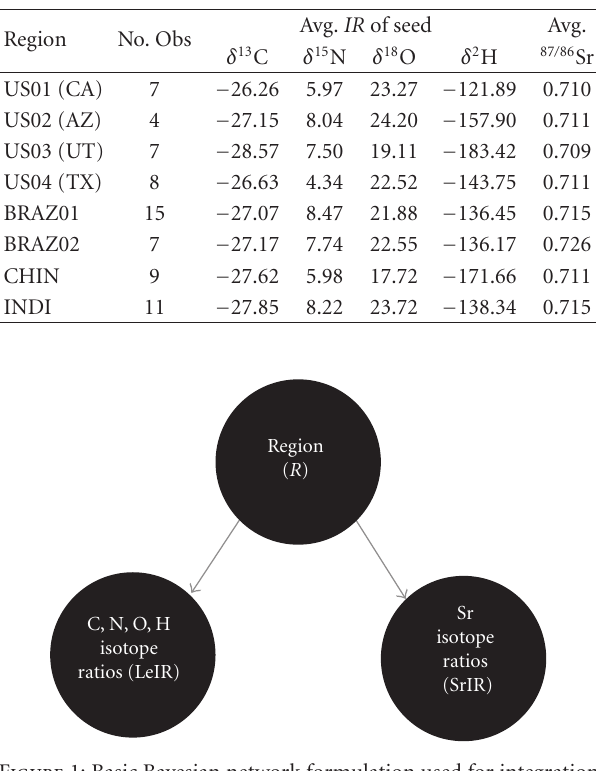
Figure 1: Basic Bayesian network formulation used for integration of the light element and Sr isotope ratios, LeIR and SrIR, respec-